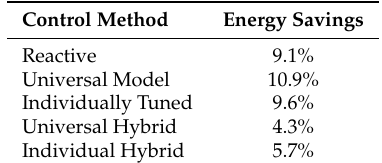
Table 9. Average energy savings by control method.